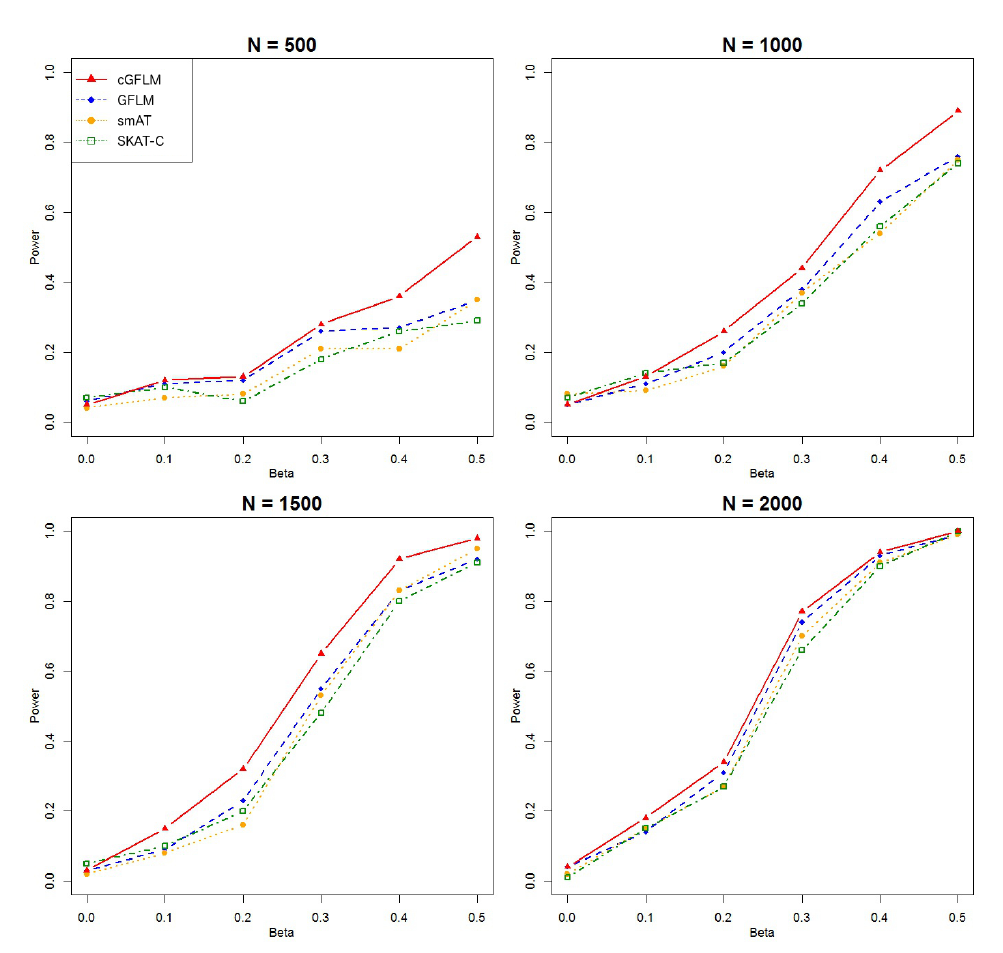
Figure 1. Power simulation for binary outcomes based on random LD blocks, single causal